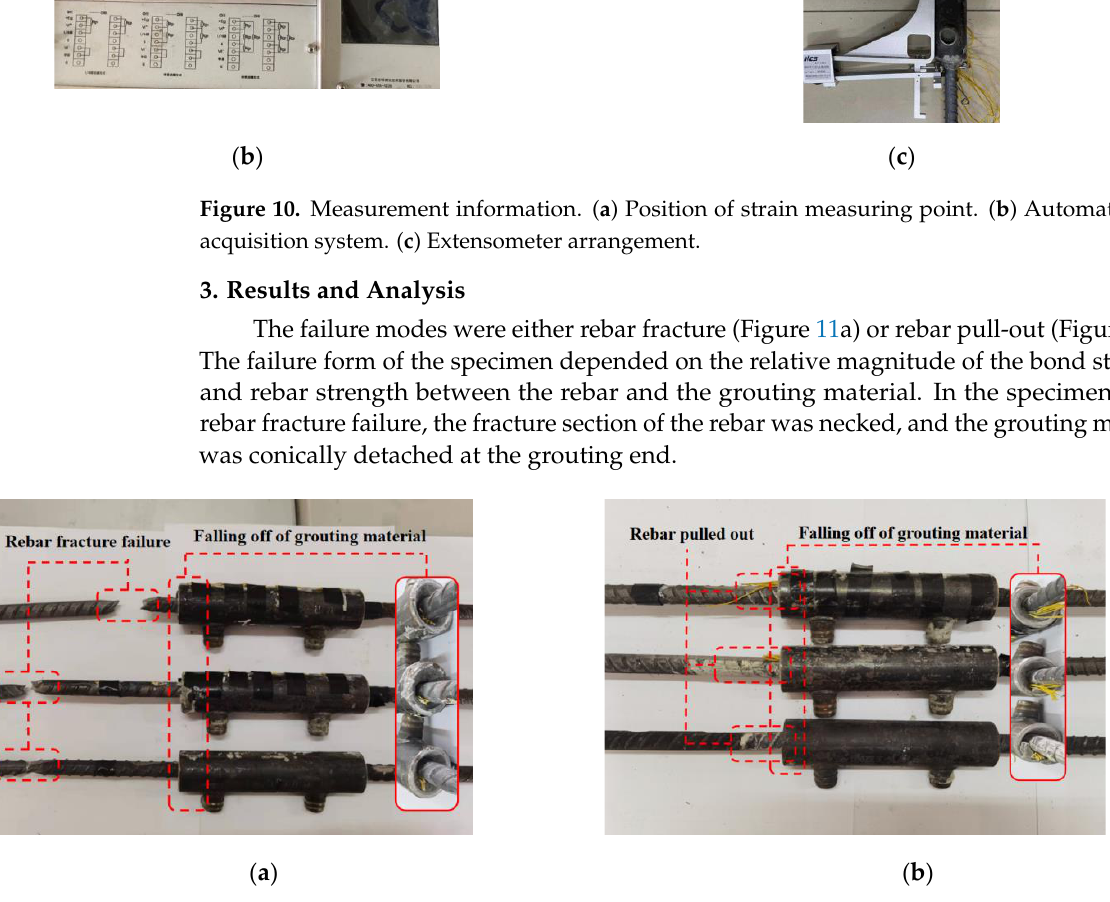
Figure 11. Failure modes. ( a ) Rebar fracture failure. ( b ) Rebar pull-out failure.